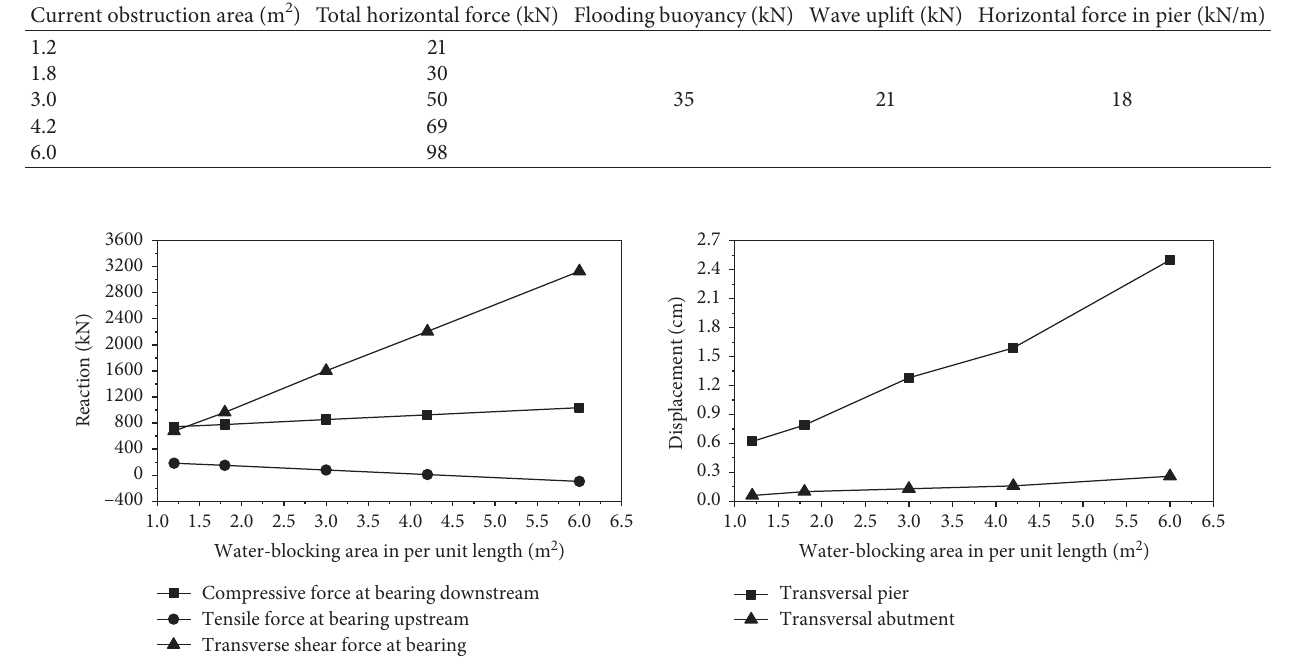
Table 13: The flood